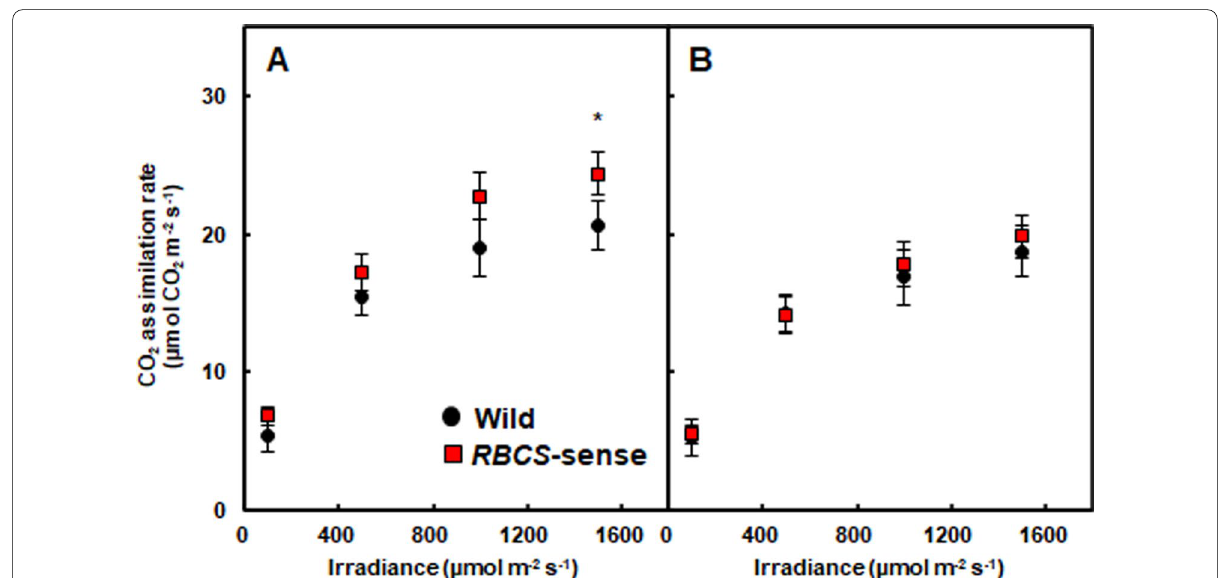
Fig. 1 CO 2 assimilation rate in the flag leaves ( A ) and penultimate leaf blades ( B ) of the wild‑type and RBCS ‑sense rice plants at the early ripening stage in the plots applied with 15 g N m − 2 fertilizer. The CO 2 assimilation rates were measured at 1 DAH for flag leaves and 4 DAH for the penultimate leaves using LI‑6400XT (Li‑Cor). Mean values the standard error of 5–7 independent rice plants is shown. The wild‑type and ± RBCS ‑sense rice plants are represented by black circles and red squares, respectively. * p < 0.05 between the wild‑type and RBCS ‑sense rice plants using Student’s t- test. The abbreviations stand as following: “DAH”; days after heading, “ RBCS ‑sense”; transgenic rice plants overproducing Rubisco, “Wild”, wild‑type rice